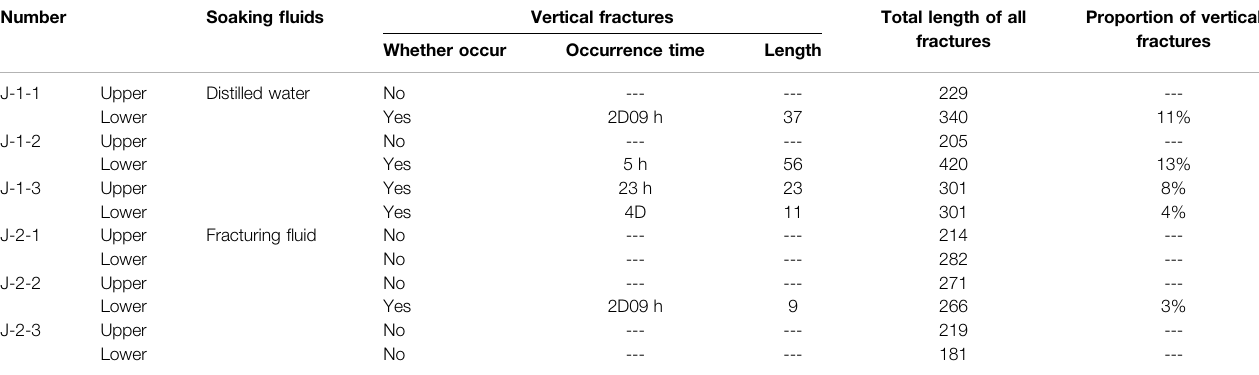
TABLE 4 | Statistics of length of vertical hydration crack of specimens soaking in puri fi ed water and fracturing fl uid (Unit: